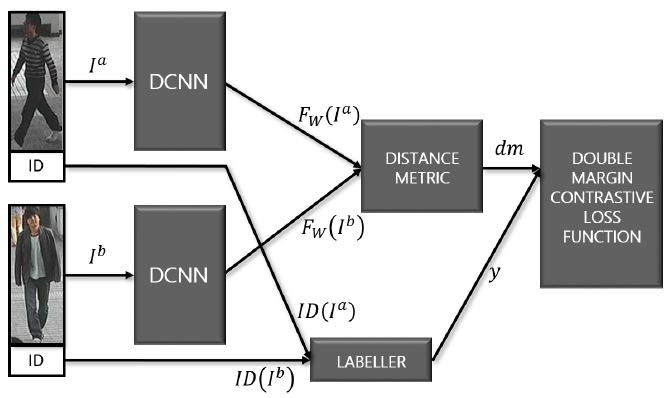
Figure 7. Architecture of the Siamese